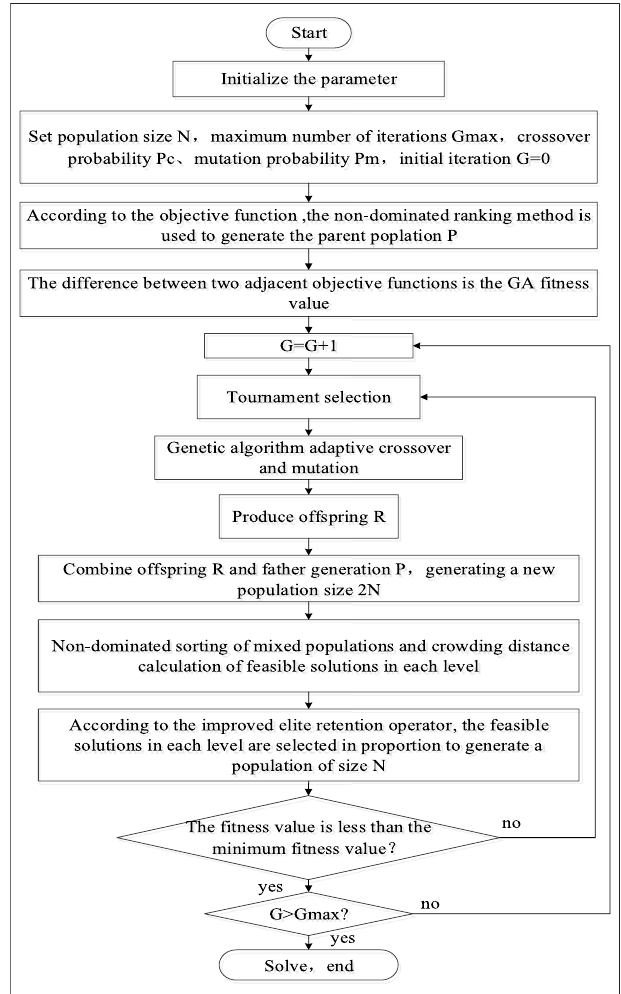
FIGURE 4 | Improved GA algorithm solving process.